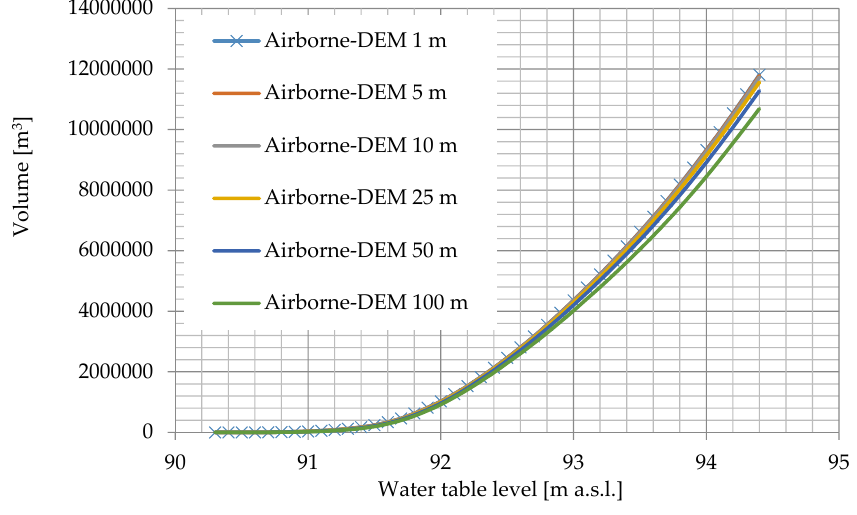
Water table level [m a.s.l.] Figure 6. Comparison of the polder volume depending on the resolution of the Airborne-DEM.